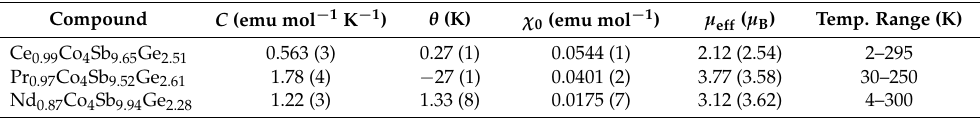
Table 4. Curie constant ( C ), Weiss temperature ( θ ), a paramagnetic term ( χ 0 ) and the effective moment µ eff (with theoretical values in parentheses) derived from regression calculations using a modified Curie-Weiss